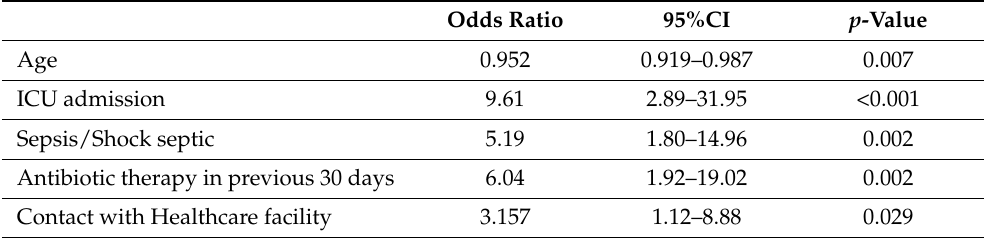
Table 5. Multivariate logistic regression analysis of risk factors for clinical failure. Odds Ratio 95%CI p -Value Age